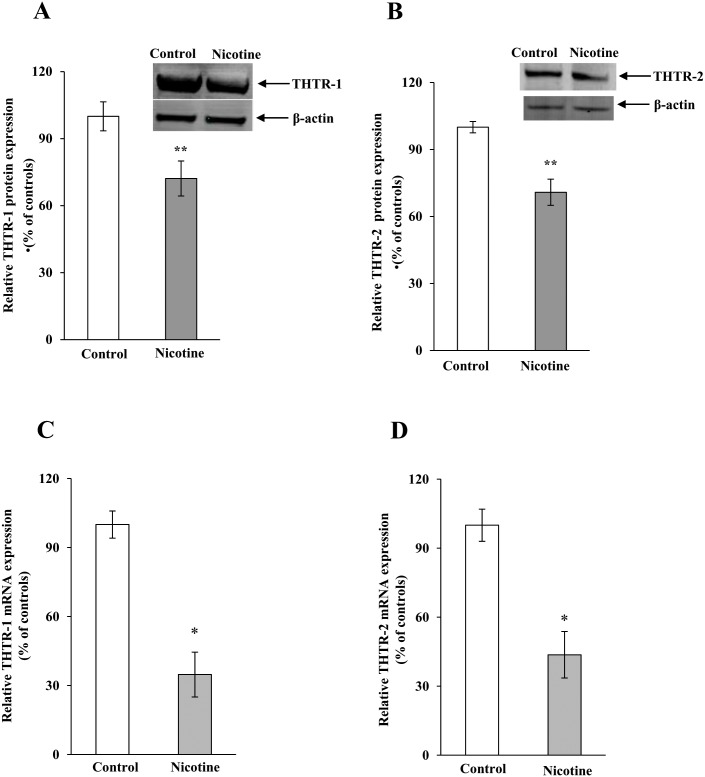
Chronic exposure of human PAC to nicotine reduces the levels of THTR-1 and THTR-2 proteins (A and B) and mRNA (C and D).Levels of THTR-1 and THTR-2 protein expression were determined by Western blotting. The mRNA expression was determined by quantitative PCR. Each data represents the mean ± SE of at least three independent experiments. *P < 0.01, **P < 0.05.